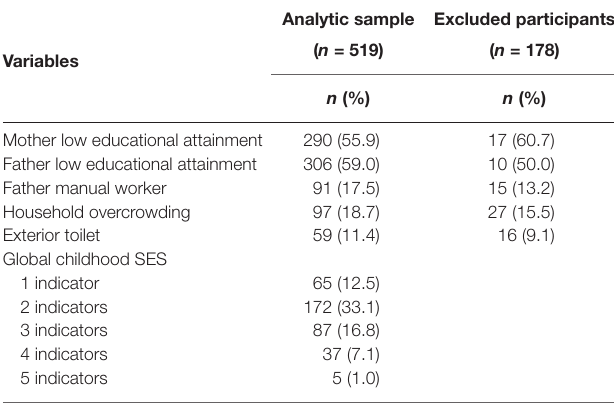
TABLE 3 | Descriptive statistics of indicators of low childhood